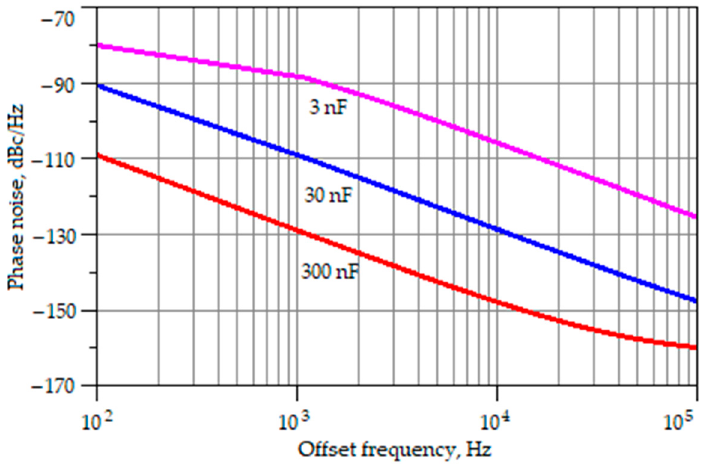
Figure 21. Phase noise versus offset frequency for the oscillator with multiple-output Wilson current mirror when R L = ∞ ; C b = 300 nF—red curve, C b = 30 nF—blue curve, C b = 3 nF—purple curve.